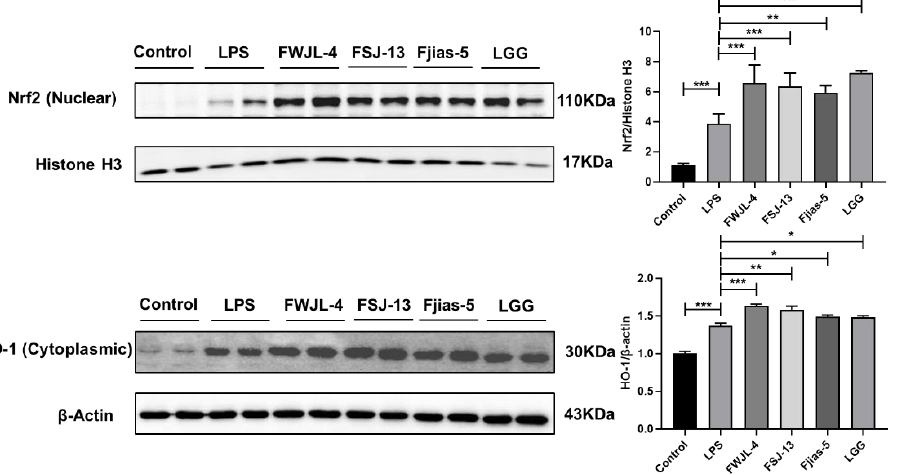
Figure 6. Selected probiotic LAB ( L. gasseri FWJL-4, L. plantarum Fjias-5 and L. rhamnosus FSJ-13) induce Nrf2-mediated signaling pathways. All data were expressed as mean ± SD. * p < 0.05; ** p < 0.01; *** p < 0.001 were considered as statistical significance. Reported statistical significance refers to comparisons with cell-treated with LPS.